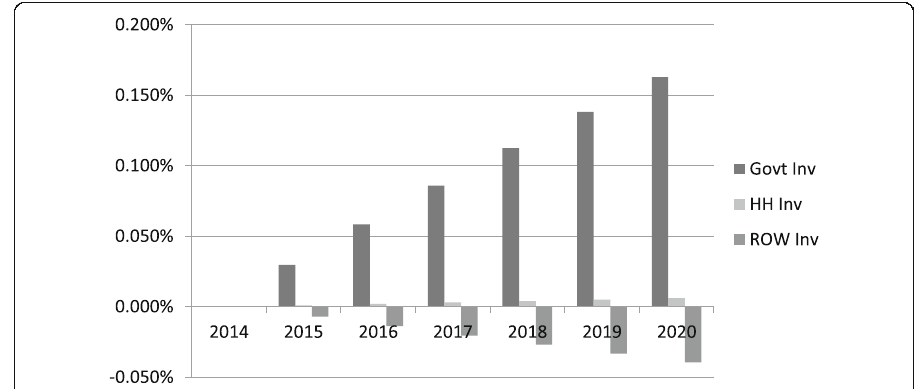
Fig. 1 Percentage change in investments of institutional sectors from the